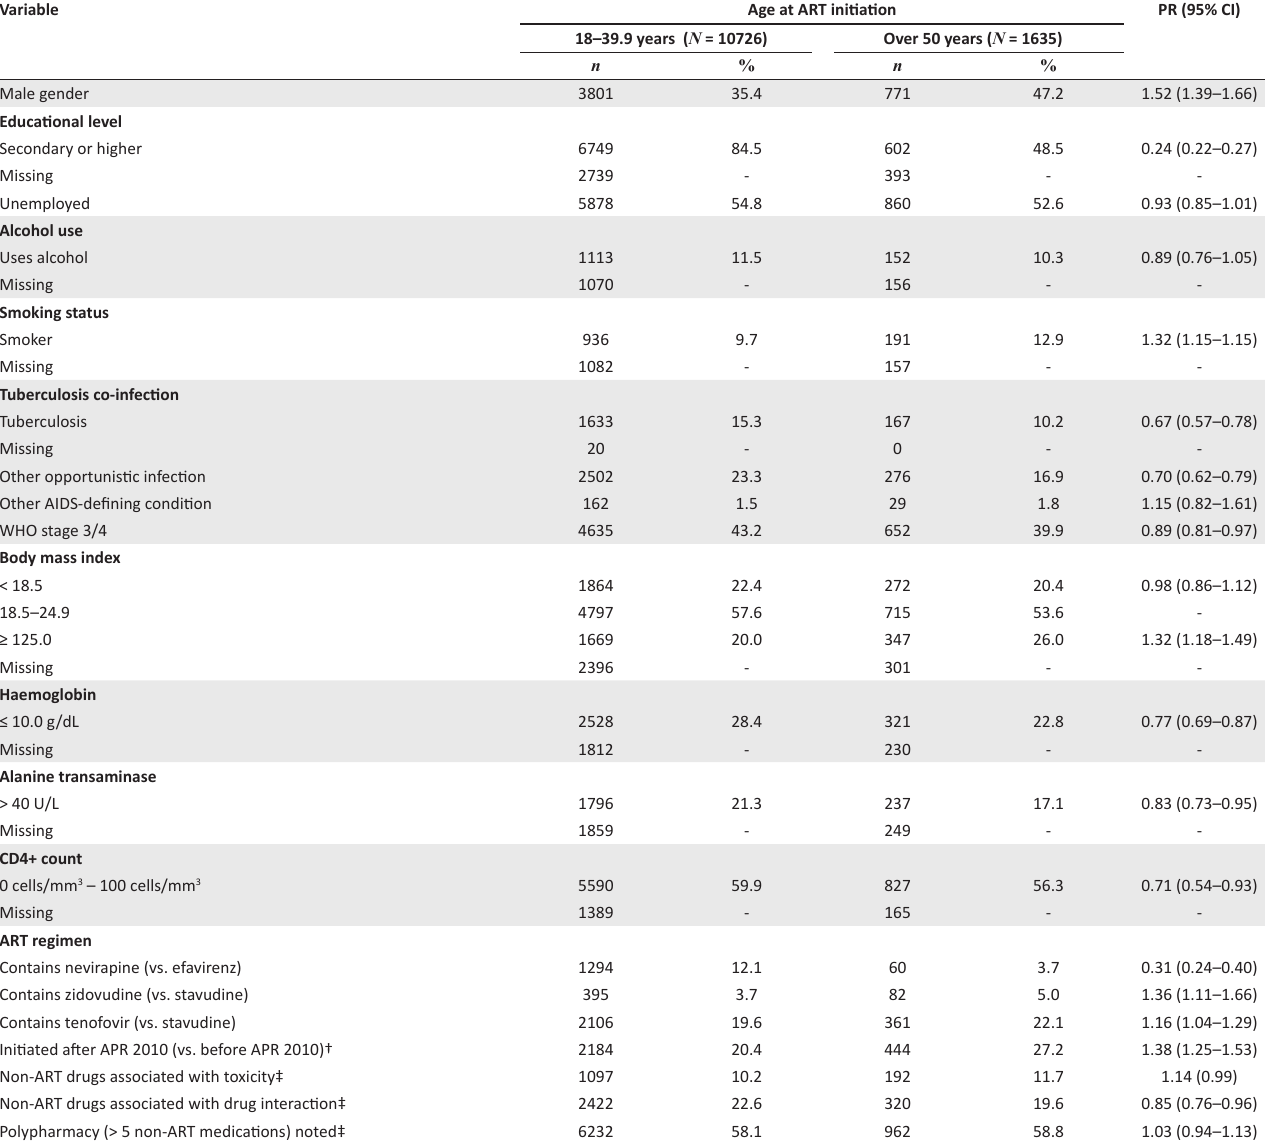
TABLE 1: Baseline demographic, clinical, laboratory and regimen characteristics at the time of antiretroviral therapy initiation. Variable